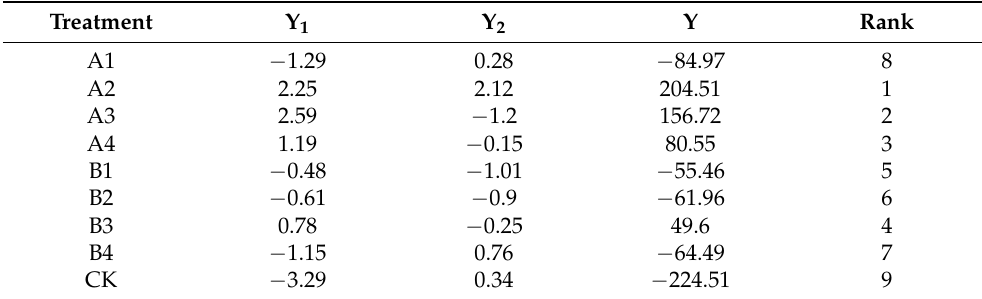
Table 8. Comprehensive score and ranking of each treatment based on the principal component analysis of cotton fiber quality